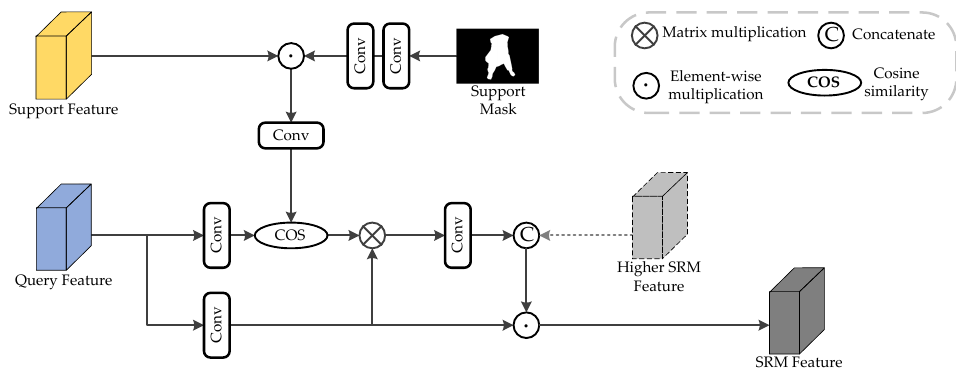
Figure 2. Similarity-Guided Feature Reinforcement Module (SRM), The “Higher SRM Feature” using the dotted line means that the last SRM module does not have this